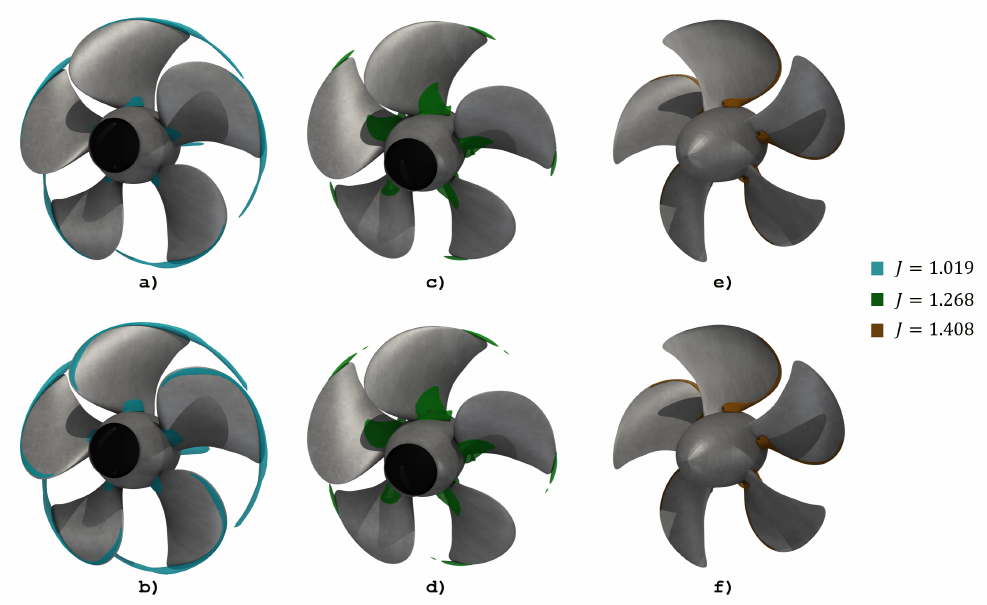
Figure 5. Cavitation patterns obtained using k- ω SST DES turbulence model. Results show good agreement with the experiment [30]. ( a ) Results for J = 1.019, σ = 2.024 at 50% vapor volume fraction and ( b ) 20% vapor volume fraction; ( c ) J = 1.268, σ = 1.424 at 20% vapor volume fraction and ( d ) 10% vapor volume fraction; ( e ) J = 1.408, σ = 1.999 at 20% vapor volume fraction and ( f ) 10% vapor volume